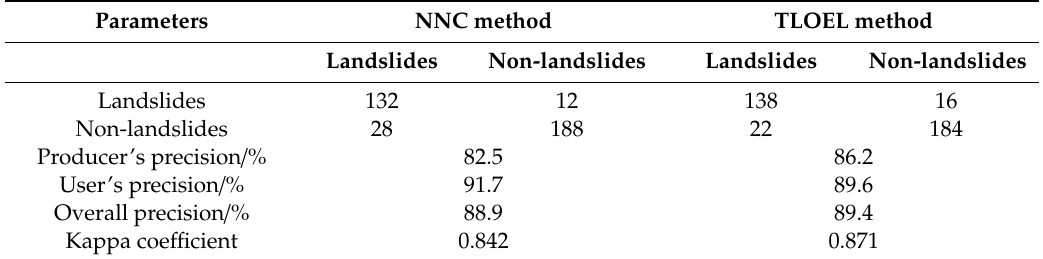
Table 6. Confusion matrix of experimental image